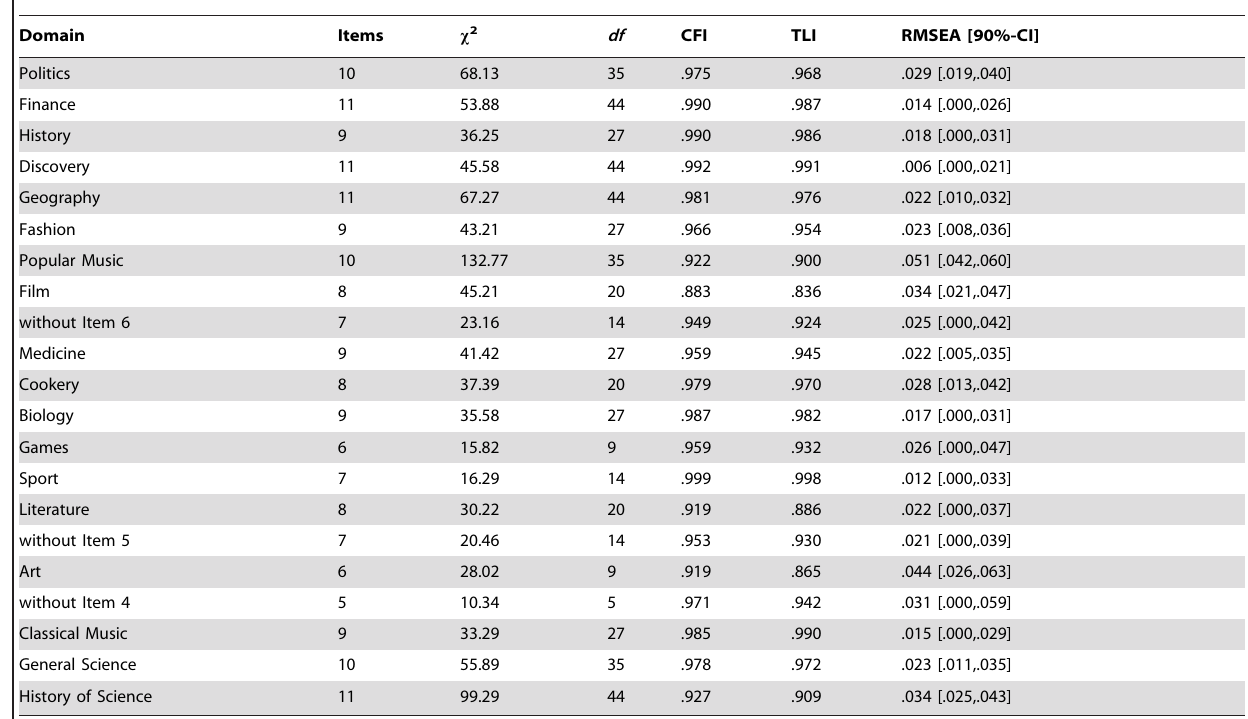
Table 2. Fit Statistics of Unidimensional Models in Domains.